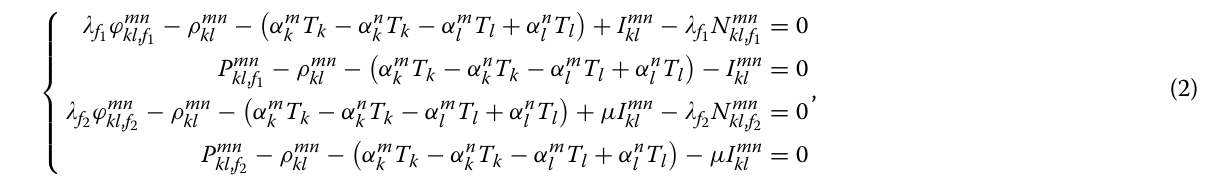
corresponds to the signal frequency. Such obtained precise DD ionospheric delays are decomposed to undifferenced values and interpolated using ordinary kriging method to an approximate posi- tion of the rover receiver (Wielgosz et al. 2003). This procedure takes advantage of the least squares estima- tion with parameter constraining to handle rank defi- ciency of the decomposition model. Finally, the absolute ionospheric corrections are converted to DD values and applied to DD observables for the rover site as described in detail in Paziewski and Wielgosz